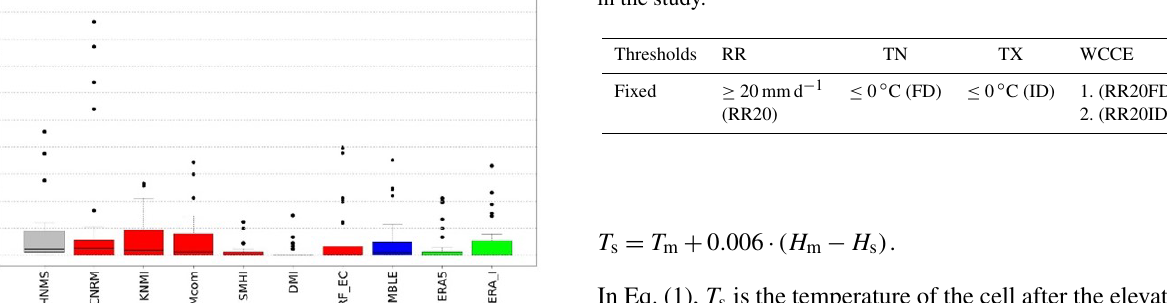
Table 2. Univariate thresholds and the compound events